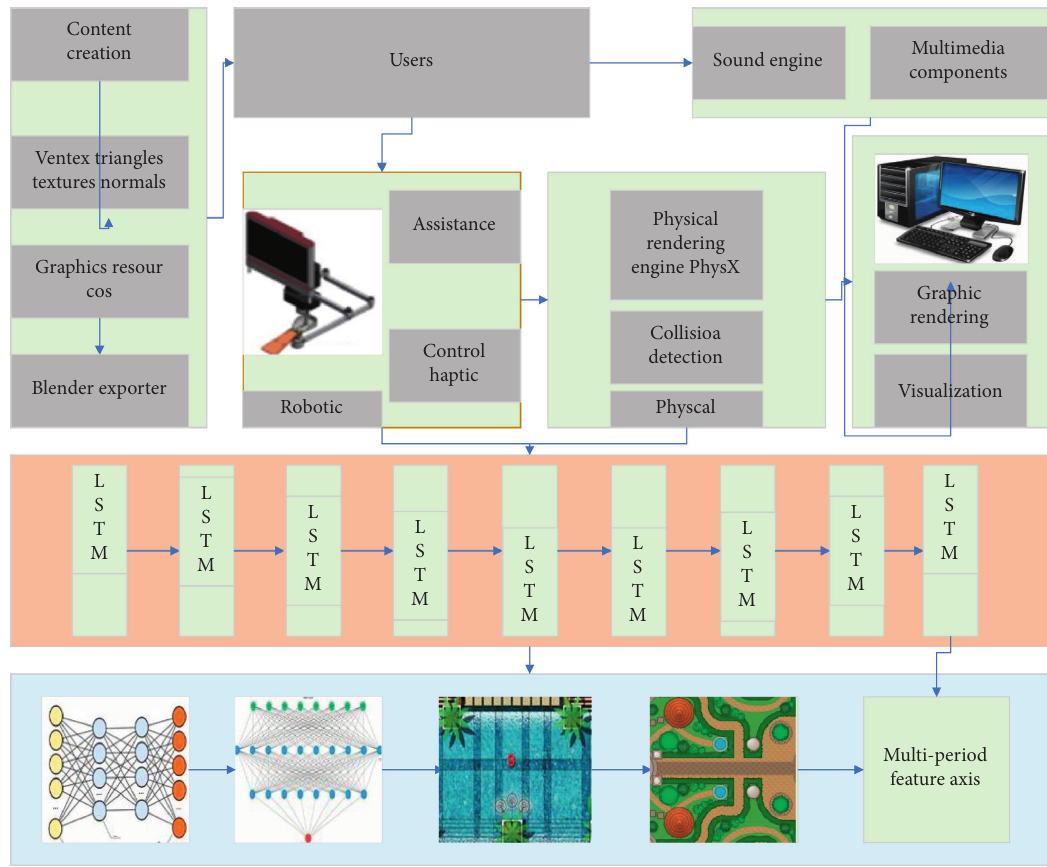
Figure 5: Two-stage training process of the model.